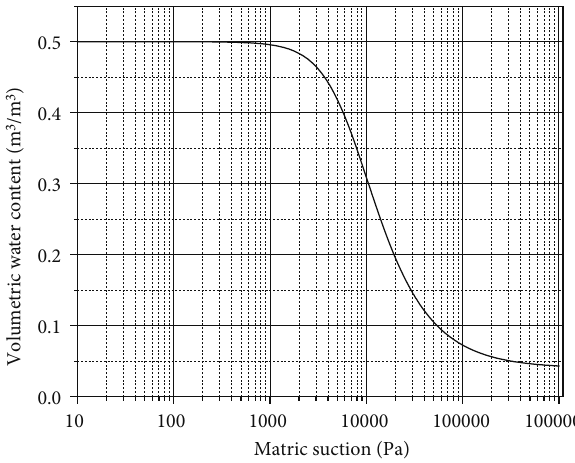
Figure 4: Soil water characteristic curve.